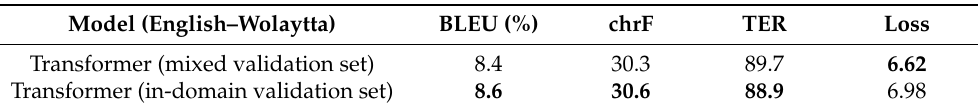
Table 7. BLEU, chrF, and TER scores of NMT models trained on the combination of synthetic and authentic datasets for English–Wolaytta translation.